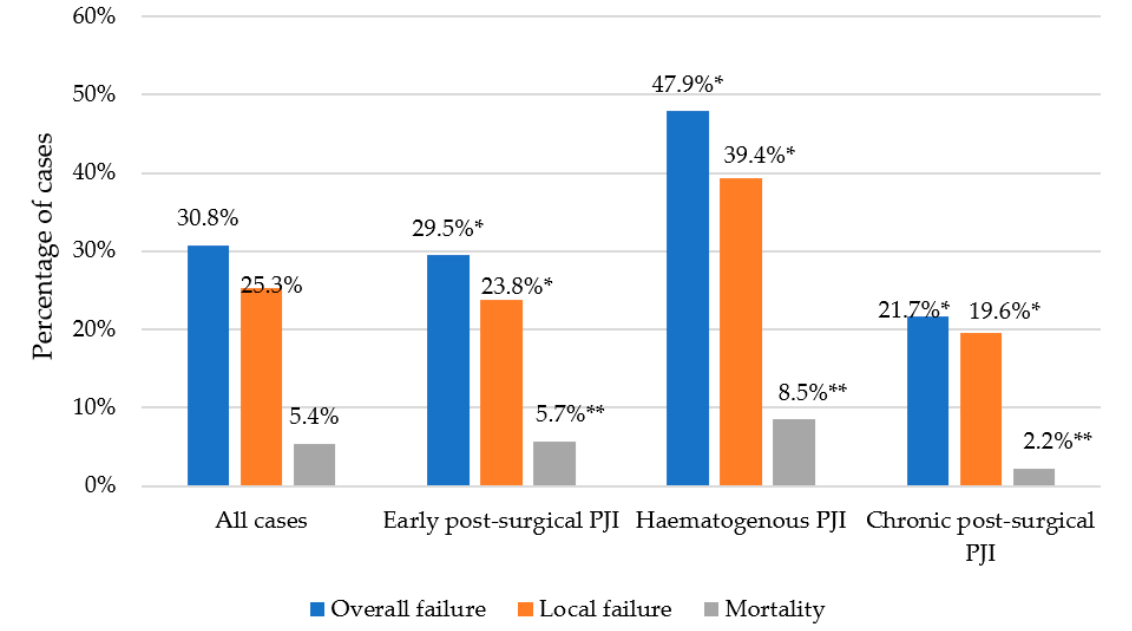
Figure 1. Outcomes of cases with prosthetic joint infection (PJI) by Staphylococcus aureus according to the type of infection. * p value < 0.01 in overall and local failure between hematogenous, early post-surgical, and chronic post-surgical PJI; ** p value = 0.201 in mortality between hematogenous, early post-surgical, and chronic post-surgical PJI.